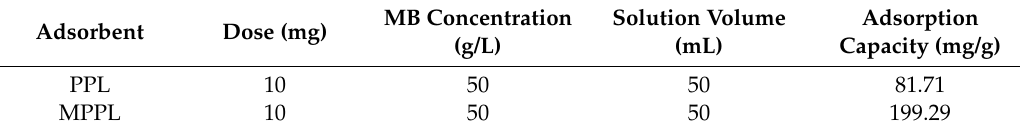
Table 1. Comparison of MB adsorption on PPL before and after modification.